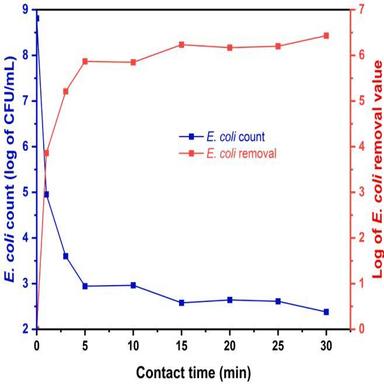
The performance the UVA/TAX process for inactivating E. coli (pH: 7; RDV: 10 mg/L; catalyst: 50 mg/L).